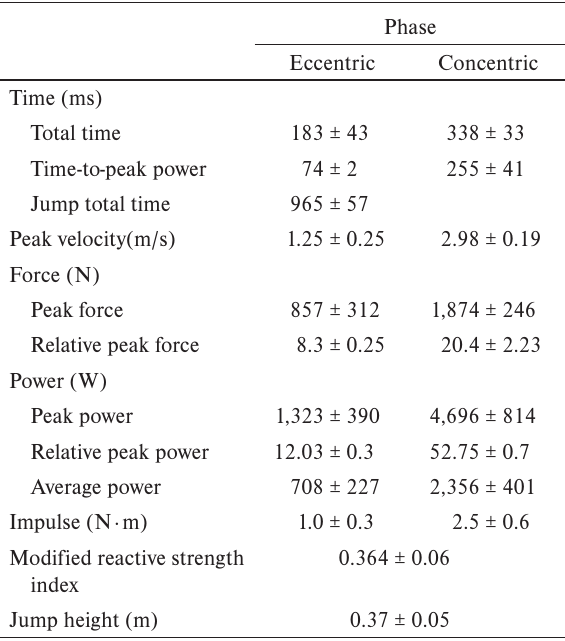
Descriptive measures of F-T curve variables in the eccen- tric and concentric phases